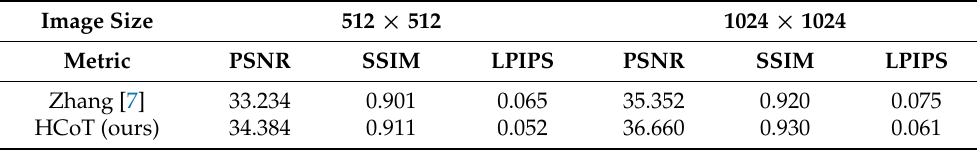
Table 3. Experimental results on higher resolution